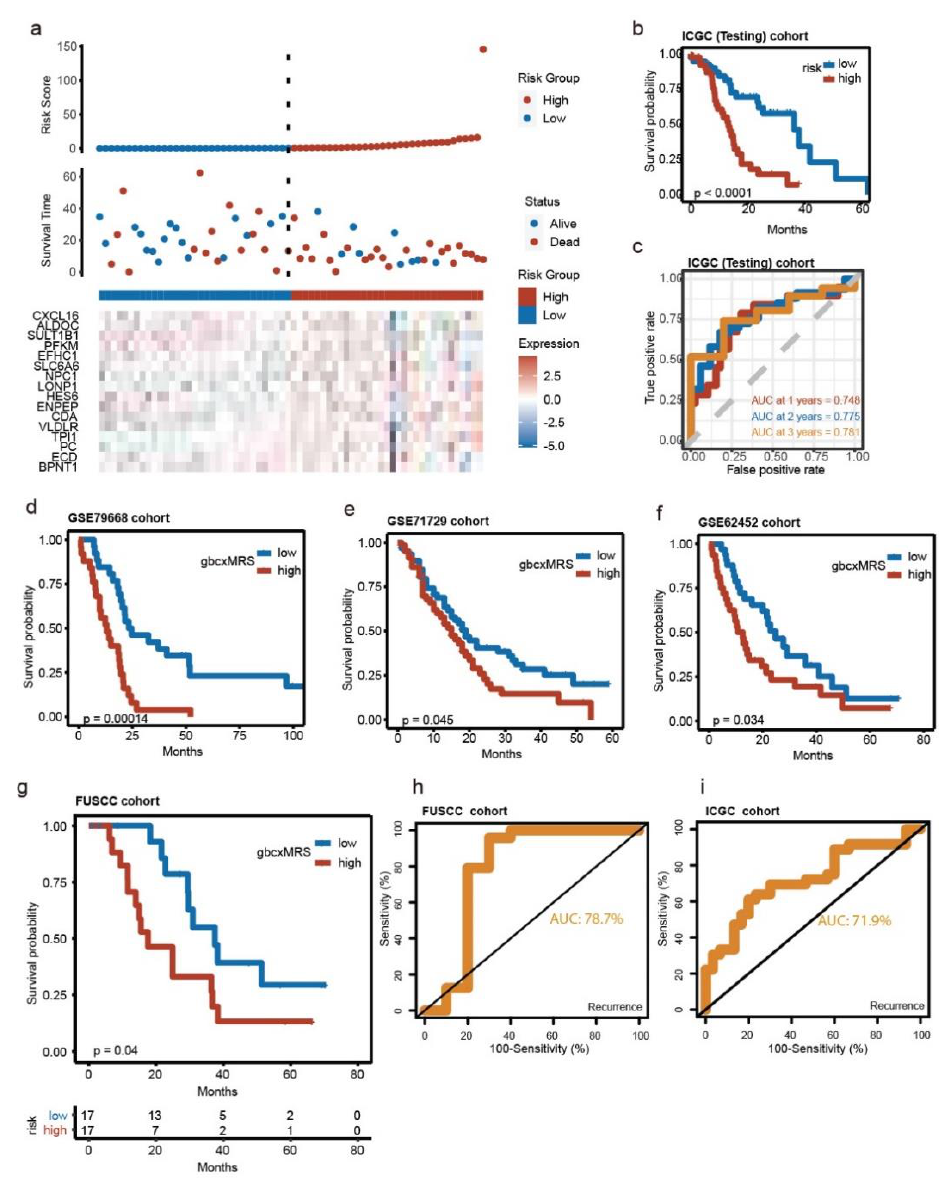
Figure 4. Robust and repeated validation of the 16-gene signature in external cohorts. ( a ) The landscape of the gbcxMRS, survival status and gene expression in the ICGC cohort. ( b ) Kaplan–Meier survival analysis between high ( n = 33) and low ( n = 33) gbcxMRS groups in the ICGC cohort. ( c ) AUC of 1-, 2- and 3-year time-dependent ROC curves. ( d – f ) Kaplan – Meier survival analysis of high